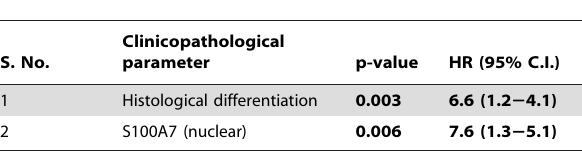
Table 3. Correlation of Overall Survival with Clinicopathological Parameters and S100A7 Expression: Multivariate